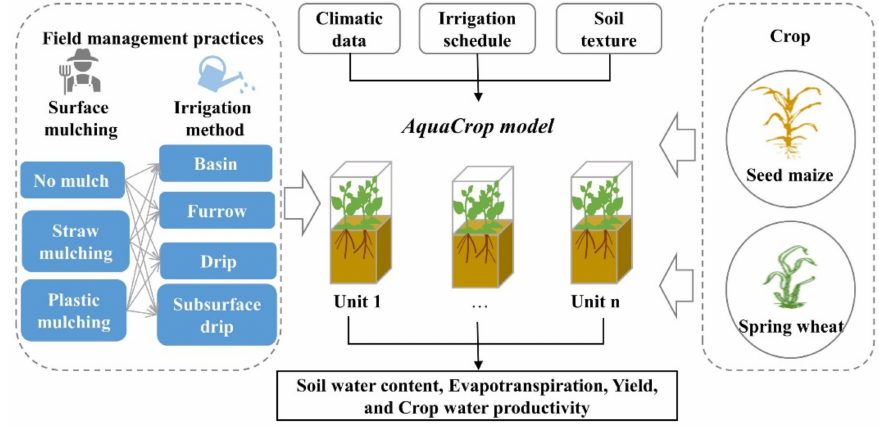
Figure 2. Schematic flowchart of the study. Table 3. Parameters of field management practices used in